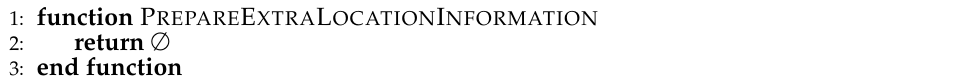
Algorithm 3 : at producer P , prepare extra location information (Fixed-brokers architecture)